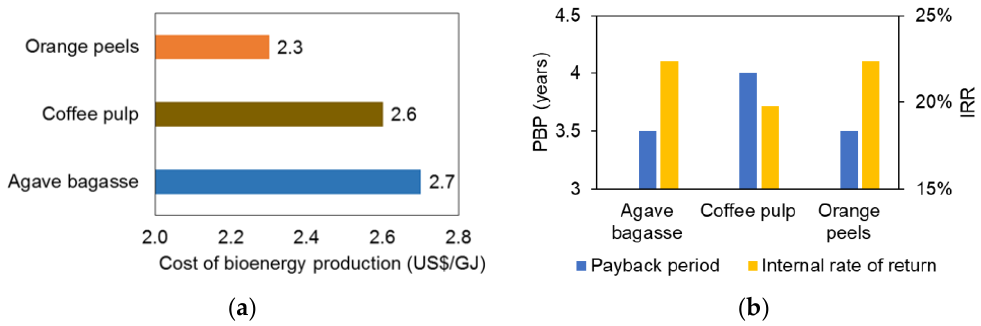
Figure 6. Results of the Bioenergy economic assessment module for : (a ) Cost of bioenergy produc- tion and ( b ) payback period (PBP) and internal rate of return (IRR) of the CHP systems using agave bagasse, coffee pulp and orange peels.